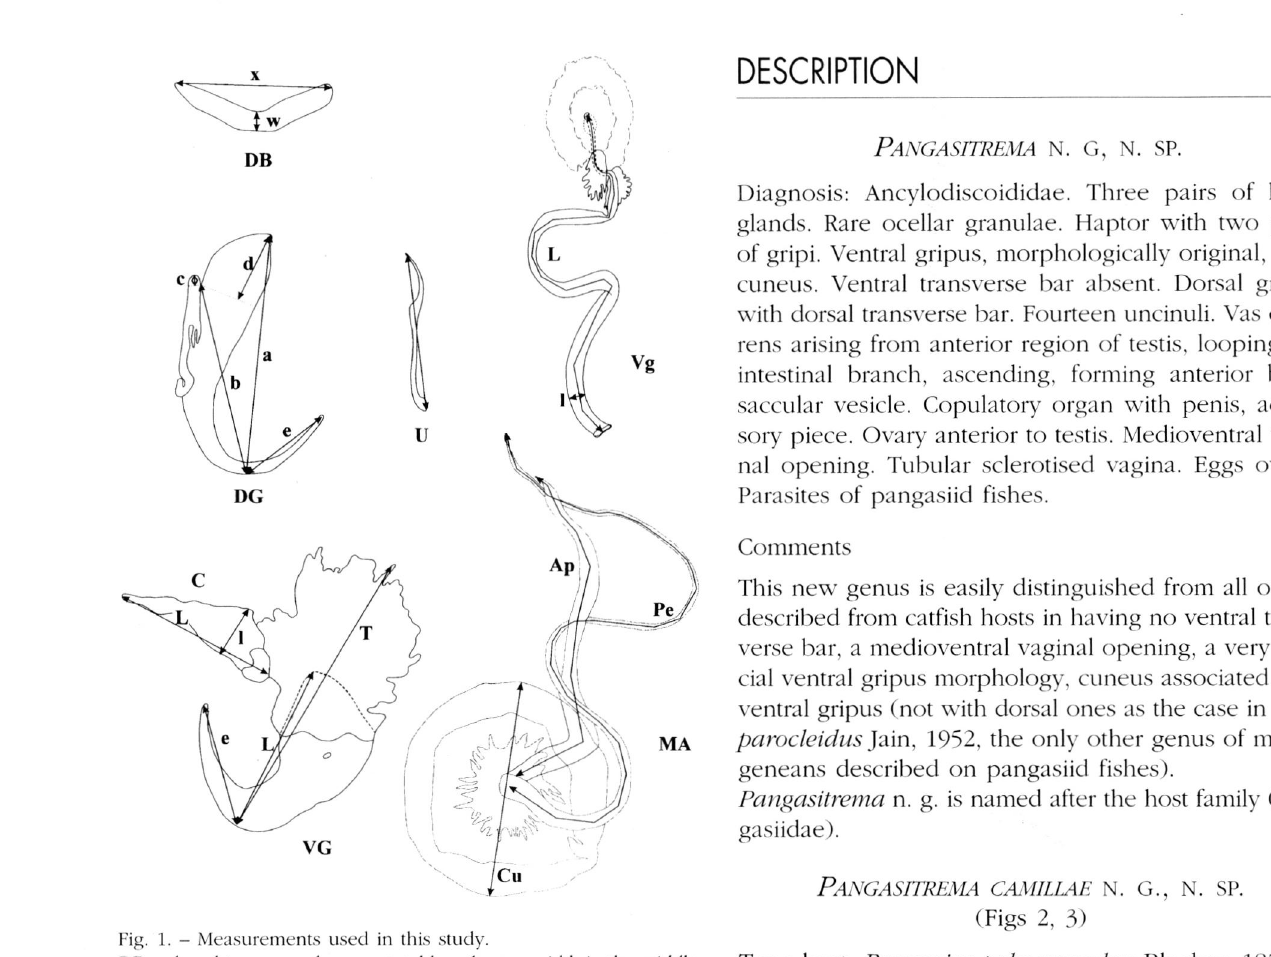
Fig. 1. - Measurements used in this study. DB - dorsal transverse bar: x = total length; w = width in the middle. DG = dorsal gripus: a. b, c, d and e = standard measurements. U = total length of the uncinuli. Vg = vagina: L = total length: 1 = maximum width. C = cuneus: L = length: 1 = largest width. VG = ventral gripus: T = total length including fibrous parts; L = total length; e = standard measurements of the point. MA = male apparatus: Pe = total length of the penis; Ap = length of the accessory piece; Cu = cupule like structure maximum dia